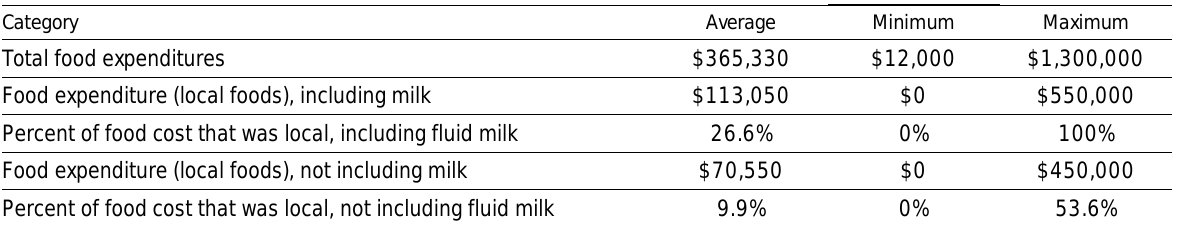
Table 3. Total Food Expenditures and Local Food Expenditures Reported by Southern Arizona School Food Authorities (SFAs) (all currency in US$)